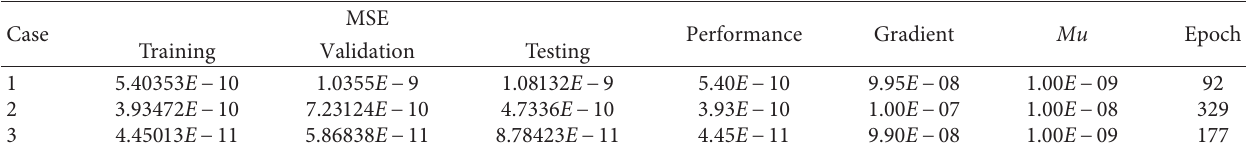
Table 2: Data of LMA-BANN for scenario 2 of the MPFPCMI.